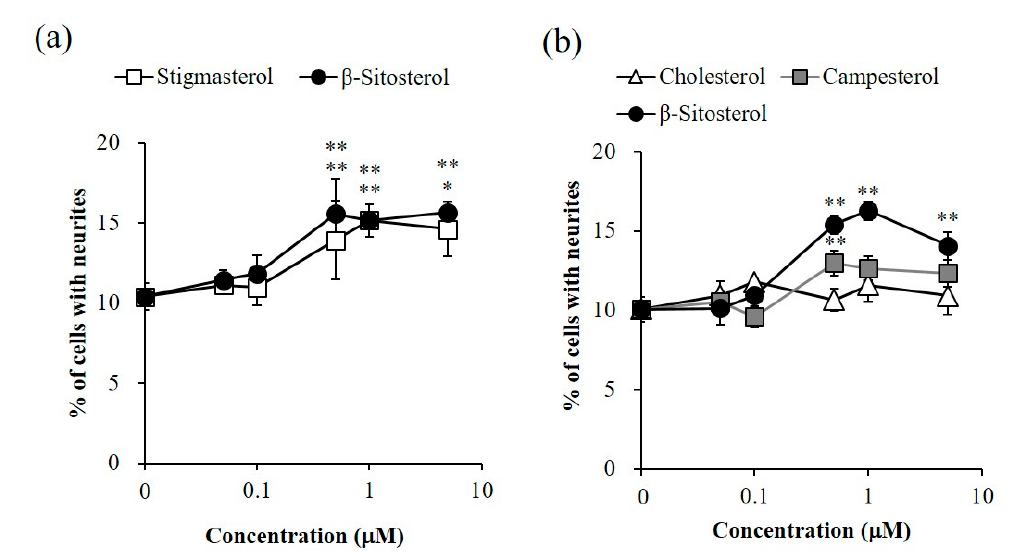
Figure 4. Neurite outgrowth-promoting activities of sterols in the presence of Bt 2 cAMP in PC12 cells. ( a ) Promotion by β -sitosterol and stigmasterol of neurite formation induced by Bt 2 cAMP in PC12 cells. ( b ) Promotion by β -sitosterol, campesterol and cholesterol of neurite formation induced by Bt 2 cAMP in PC12 cells. PC12 cells were plated at 4.0 × 10 3 cells/well and cultured with the samples at 0.05–5 μ M in the presence of 0.5 mM of Bt 2 cAMP. The extent of neurite outgrowth was measured at 24 h and is expressed as the mean percentage of 300–400 cells. The data represent means ± standard deviation (SD) from three independent experiments. * p < 0.05, ** p < 0.01 (Dunnett’s test) as compared with control (0.5 mM Bt 2 cAMP only).